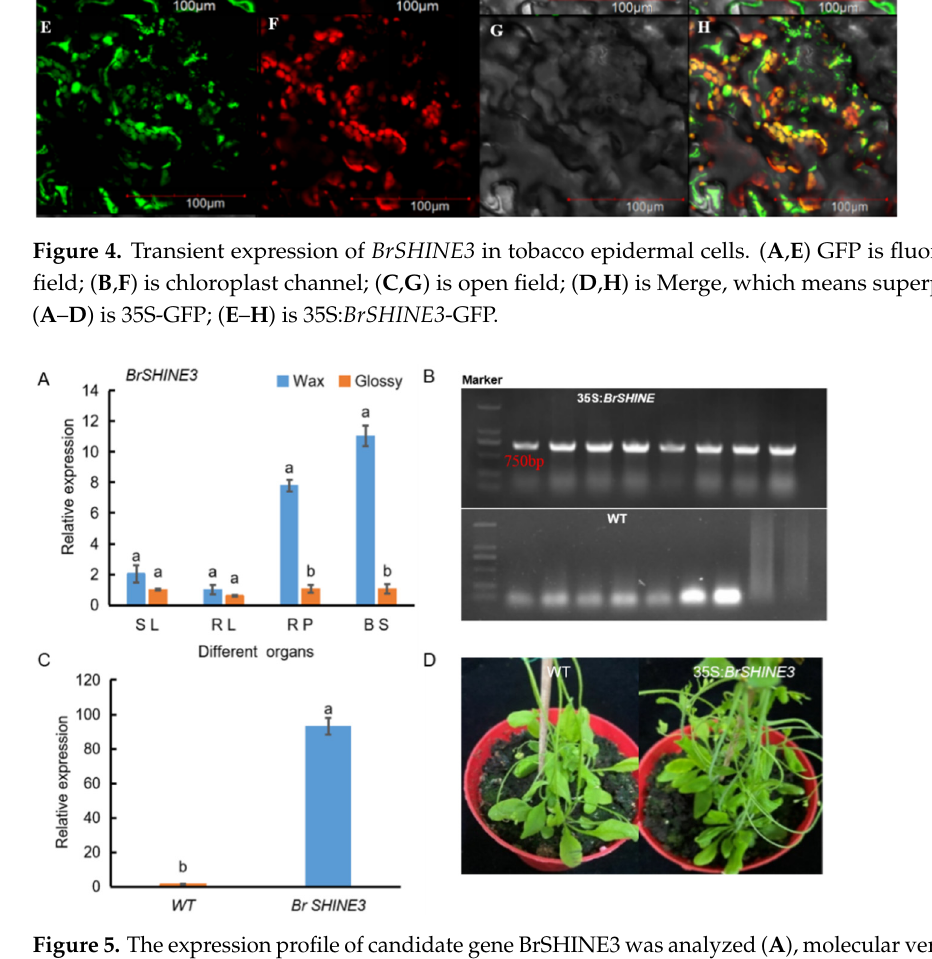
Figure 5. The expression profile of candidate gene BrSHINE3 was analyzed ( A ), molecular verification of transgenic Arabidopsis ( B ), expression level analysis of transgenic Arabidopsis ( C ) and phenotype analysis of transgenic plants ( D ). Different lowercase letters in the same column indicate significant differences at the 0.05 level among